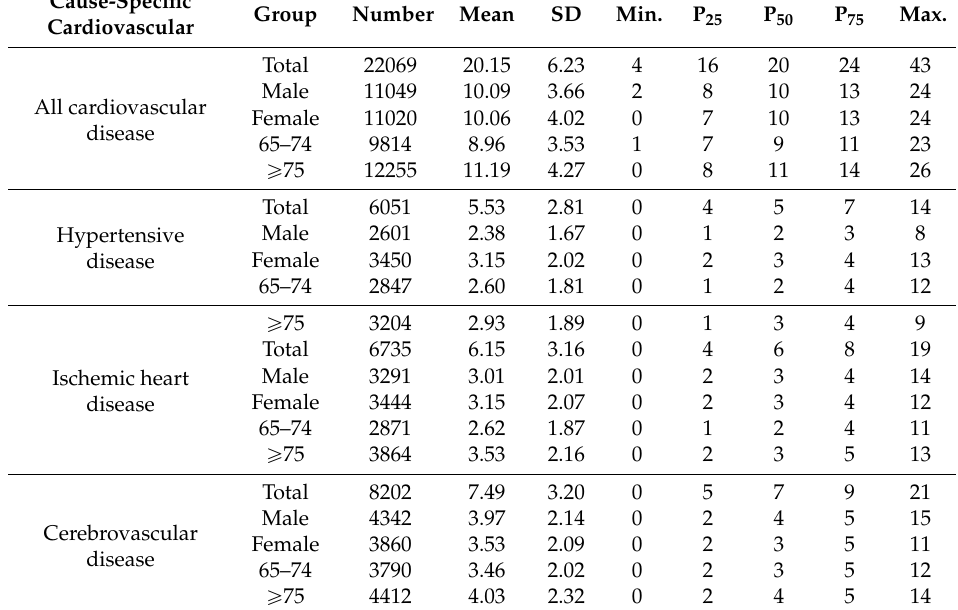
Table 1. Distribution of daily ER admissions for cause-specific cardiovascular disease among the elderly in Beijing (2009–2011).